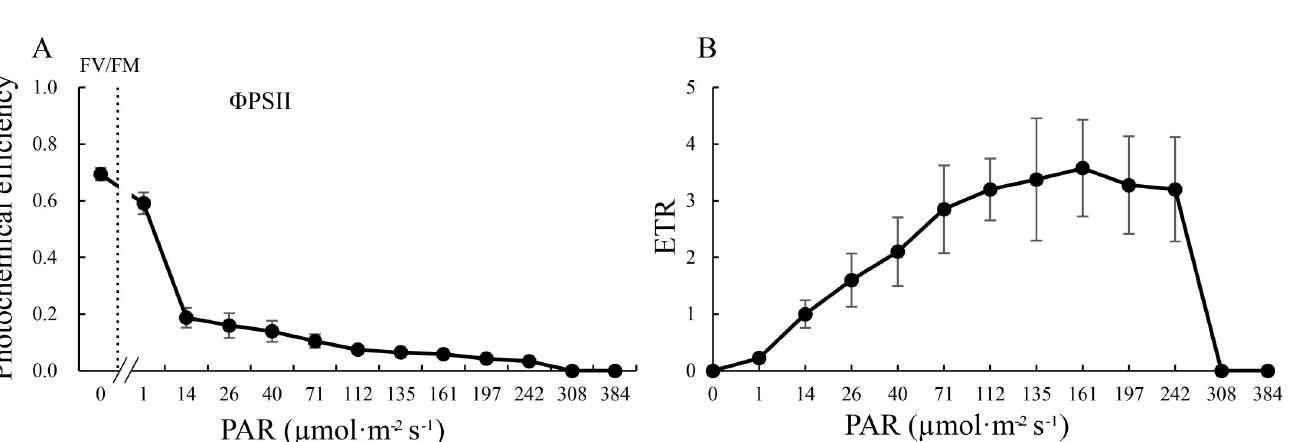
Fig 2. Light response of the PSII photochemical efficiency (A) and ETR (B) of GF tissues at S5. FV/FM, maximum quantum efficiency; F PSII, effective quantum efficiency; ETR, electron transport rate; PAR, photosynthetically active radiation.